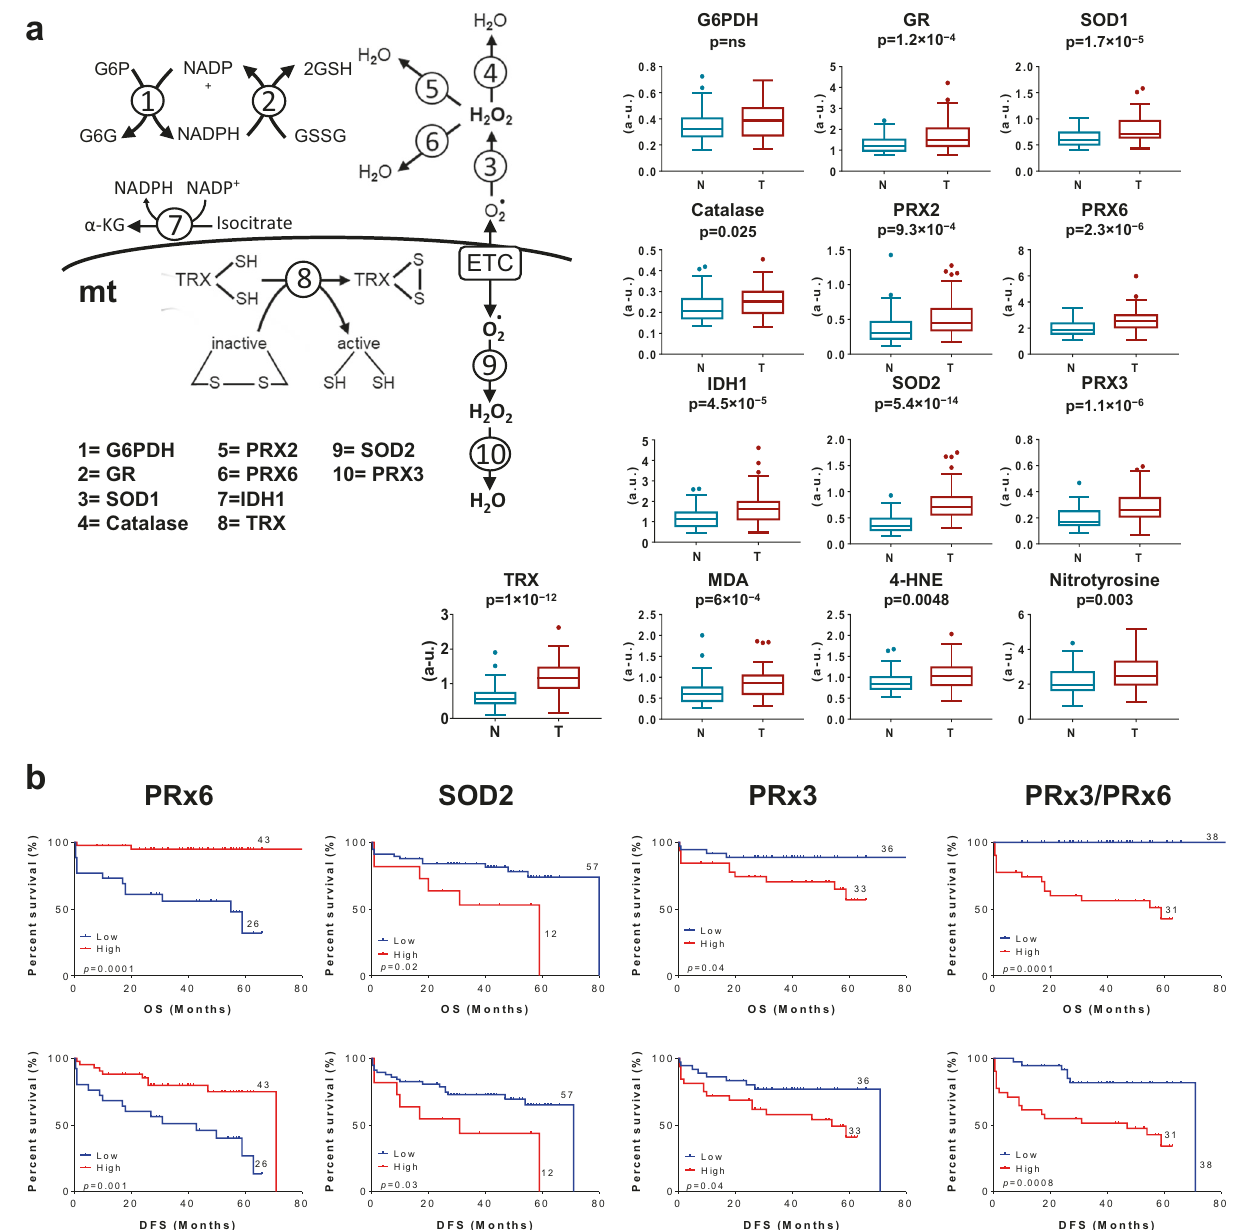
Fig. 3 Antioxidant response and oxidative stress in lung cancer: Expression and prognosis. a Representative scheme illustrating ten relevant steps involved in the antioxidant response including cytoplasmic glucose-6-phosphate dehydrogenase (G6PDH), glutathione reductase (GR), superoxide dismutase 1 (SOD1), catalase, peroxiredoxin 2 (PRX2), peroxiredoxin 6 (PRX6) and isocitrate dehydrogenase 1 (IDH1), and mitochondrial thioredoxin reductase (TRX), superoxide dismutase 2 (SOD2) and peroxiredoxin 3 (PRX3) enzymes. Box plots show the expression level of each protein, as well as the content of malondialdehyde (MDA), 4-hydroxynonenal (4-HNE) and nitrotyrosine protein adducts in non-tumor (N, n = 59) and tumor (T, n = 69) samples quanti fi ed by RPPA. The Y-axis indicates the values of intensity (a.u) calculated by interpolation in the linear plot of HCT116 cells (Supplemental Fig. S3). p -values by Student ’ s t -test are shown. b Kaplan – Meier survival analysis shows the association of the indicated markers with overall (OS) and disease-free (DFS) survival of LUAD patients strati fi ed by high (red line) and low (blue line) protein levels or value of the PRX3/PRX6 ratio. The log-rank p -values are also